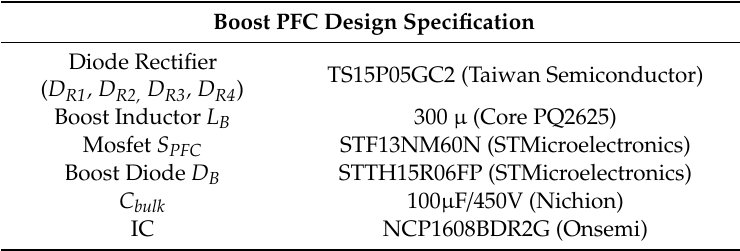
Table 2. Device list of boost PFC stage.